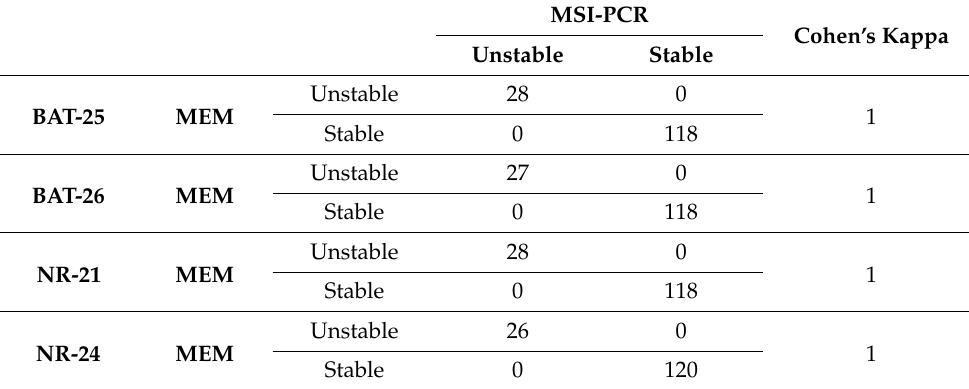
Table 2. Concordance between MSI-PCR and MEM results for BAT-25, BAT-26, NR-21 and NR-24.